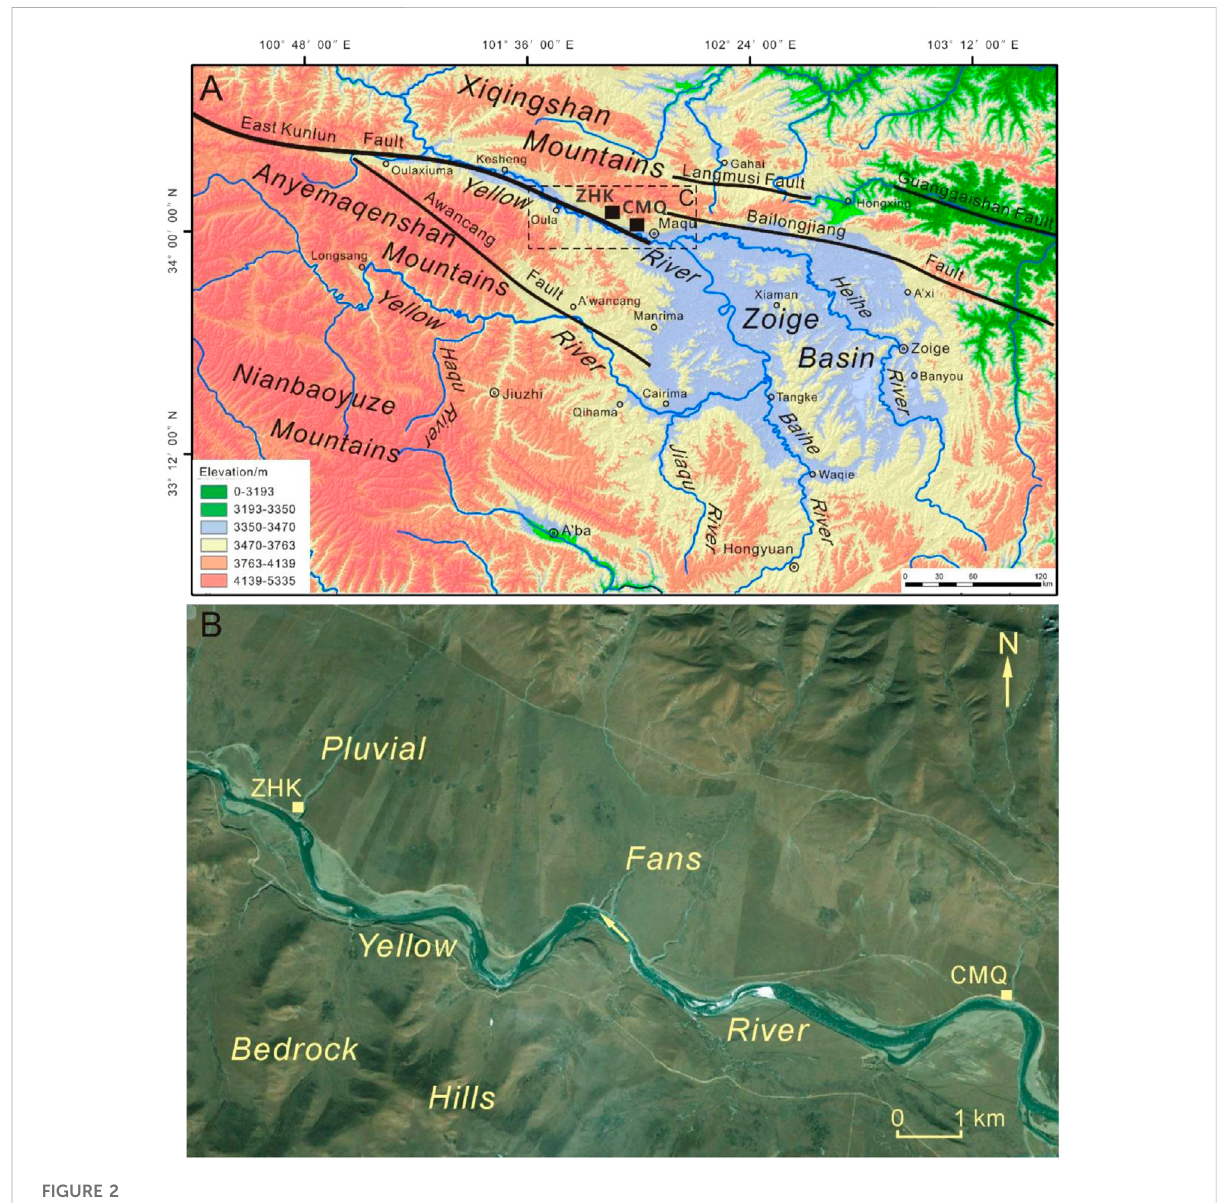
FIGURE 2 (A) Map showing the location of the CMQ and ZHK pro fi les (marked with ‘‘ ’’ ) in the Maqu-Kesheng reach downstream of the Zoige Basin. (B) Google Earth image showing the location and the landscape at the CMQ and ZHK pro fi les (marked with ‘‘ ’’